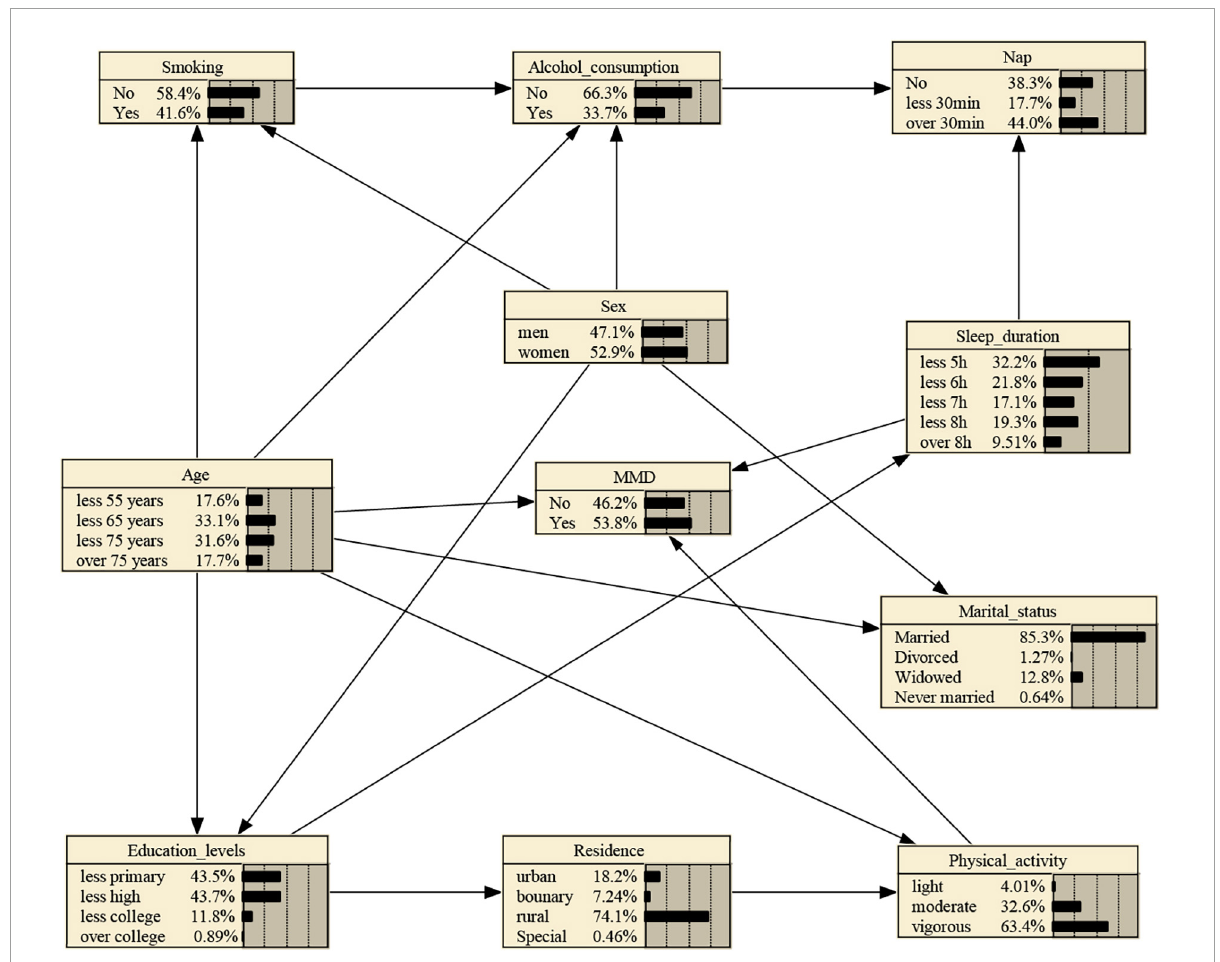
FIGURE2 MMD Bayesian networks and prior probability using MMHC Algorithm. The networks were constructed with 11 nodes and 18 directed edges. Node represents variable, and directed edges represent probabilistic dependence between connected nodes. The percentage in the figure means the prior probability of each node. Boundary: Combination zone between urban and rural